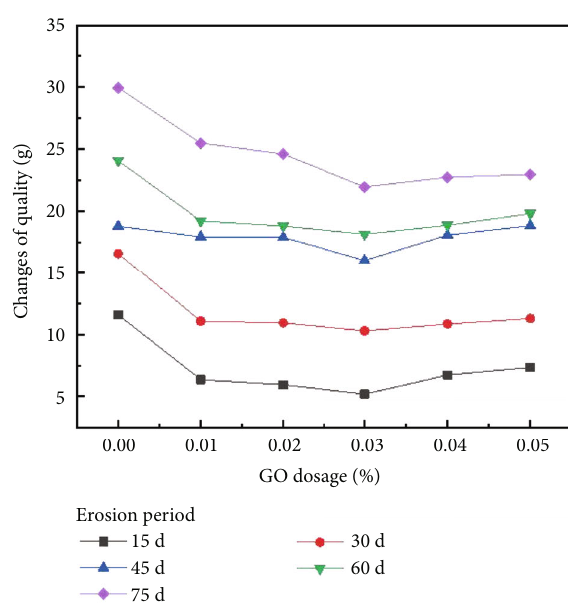
Figure 2: Quality changes of coral sand